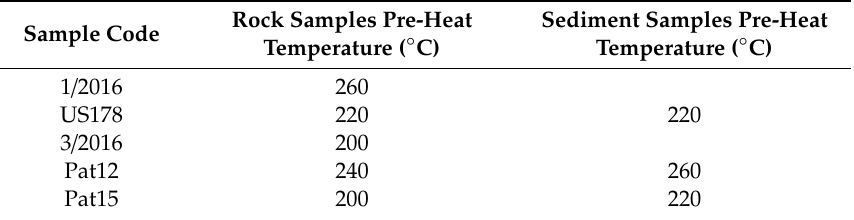
Table 2. Pre-heat temperature for rock and sediment